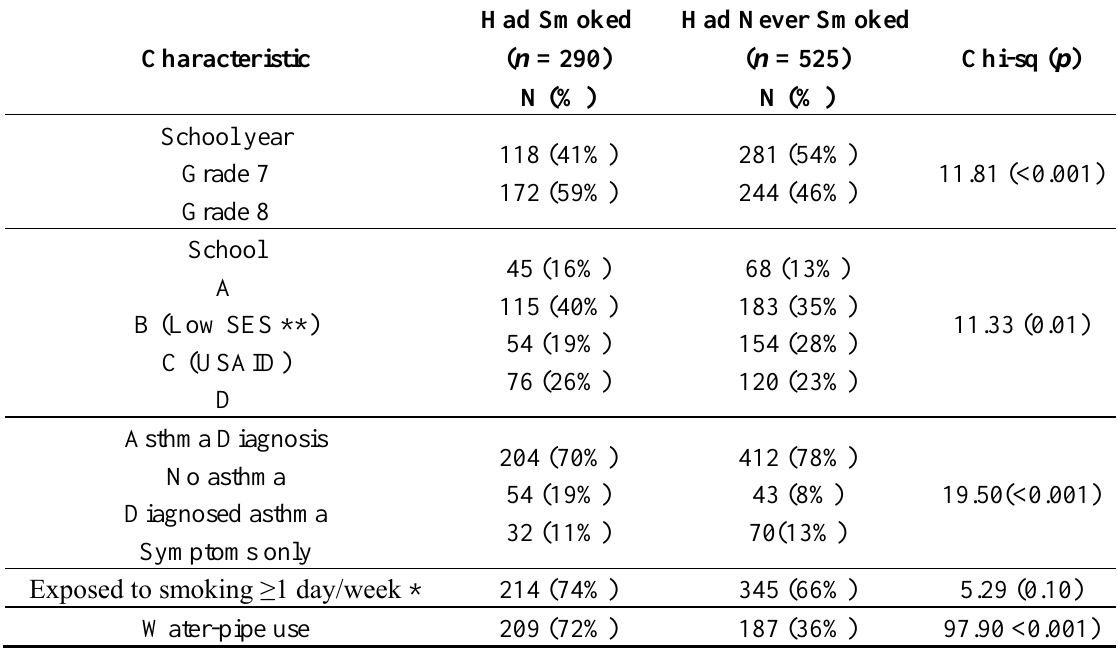
Table 3. Baseline characteristics compared for students who had ever smoked versus those who had never smoked